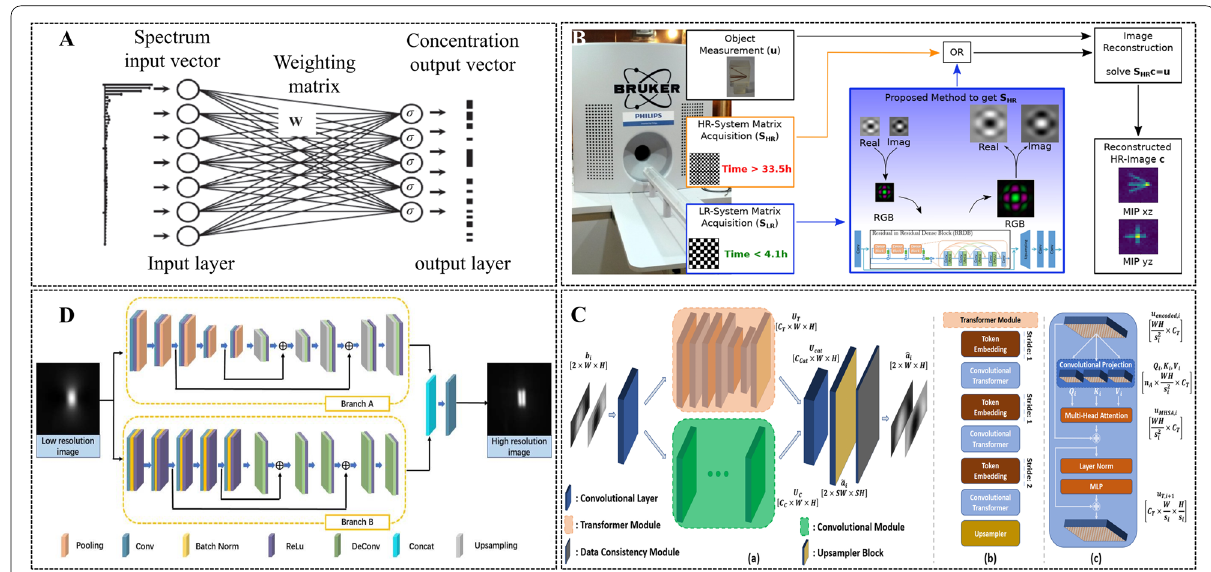
Fig. 6 Deep learning networks used in MPI. A Architecture of a single-layer neural network [67]. B Overview of the data flow of 3d-SMRnet[69]. C Schematic of TranSMS [73]. D Main framework of FDS-MPI